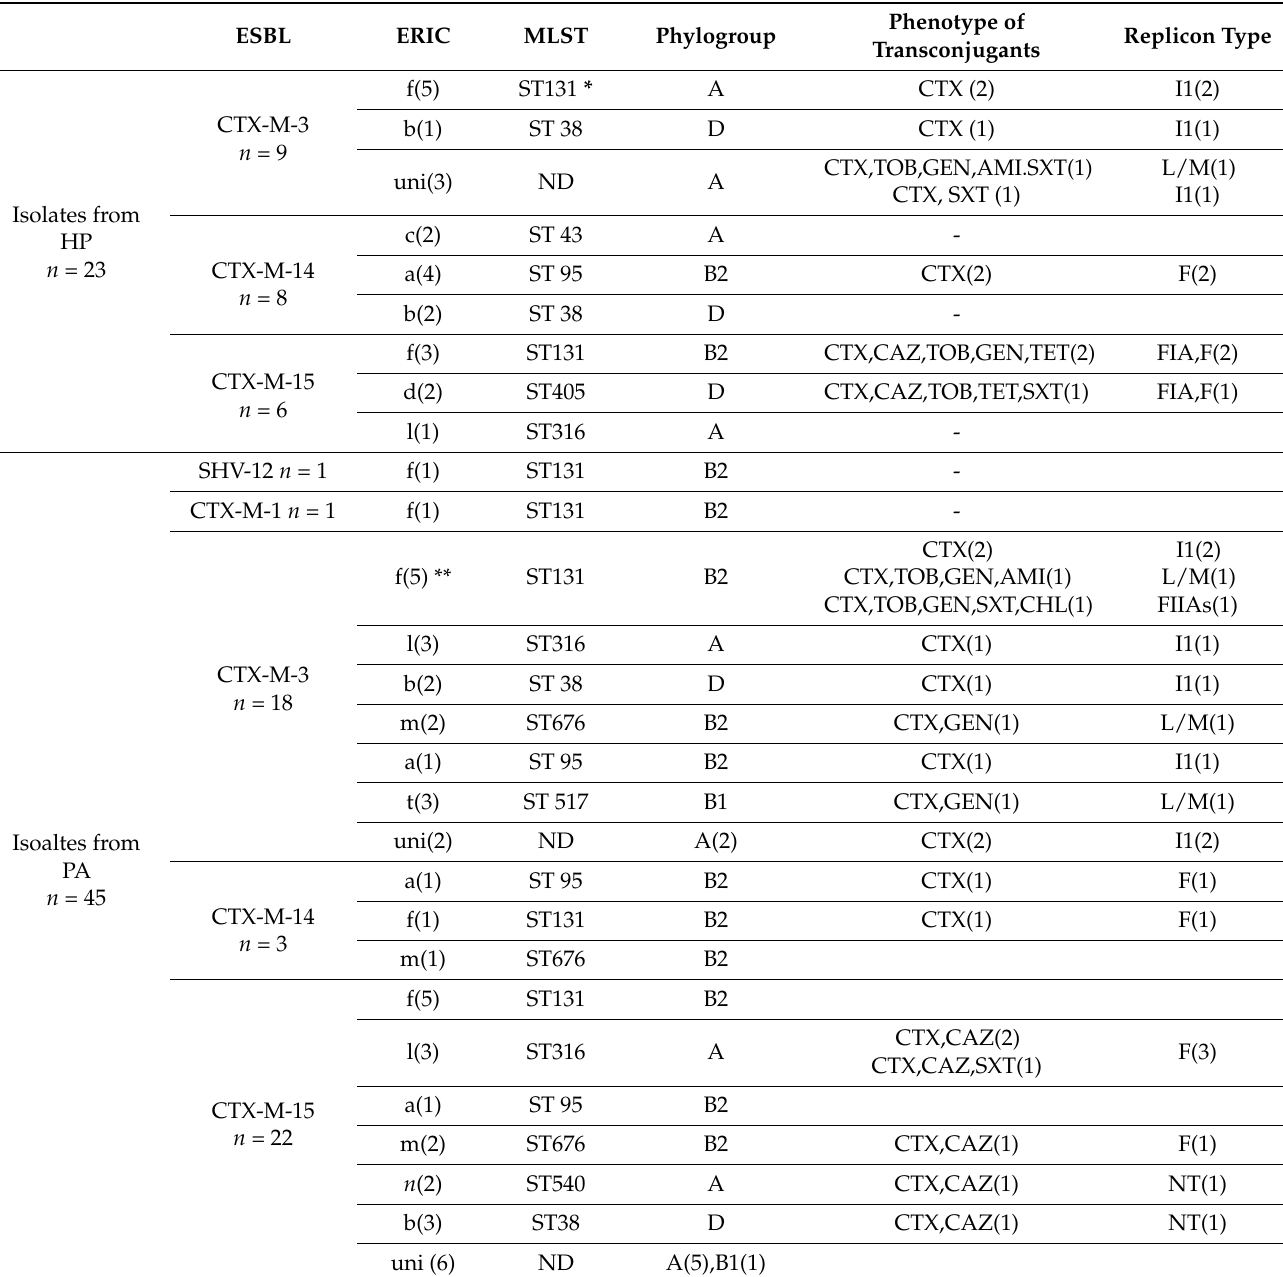
Table 3. ESBLs, MLST, replicon typing and transconjugant characteristics of 68 E . coli isolates.